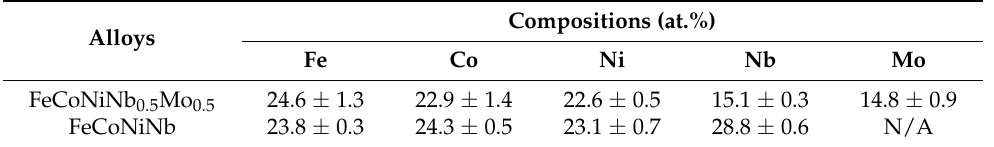
Table 1. Chemical compositions of FeCoNiNb 0.5 Mo 0.5 and FeCoNiNb alloys analyzed by SEM/EDS. Compositions (at.%) Alloys Fe Co Ni